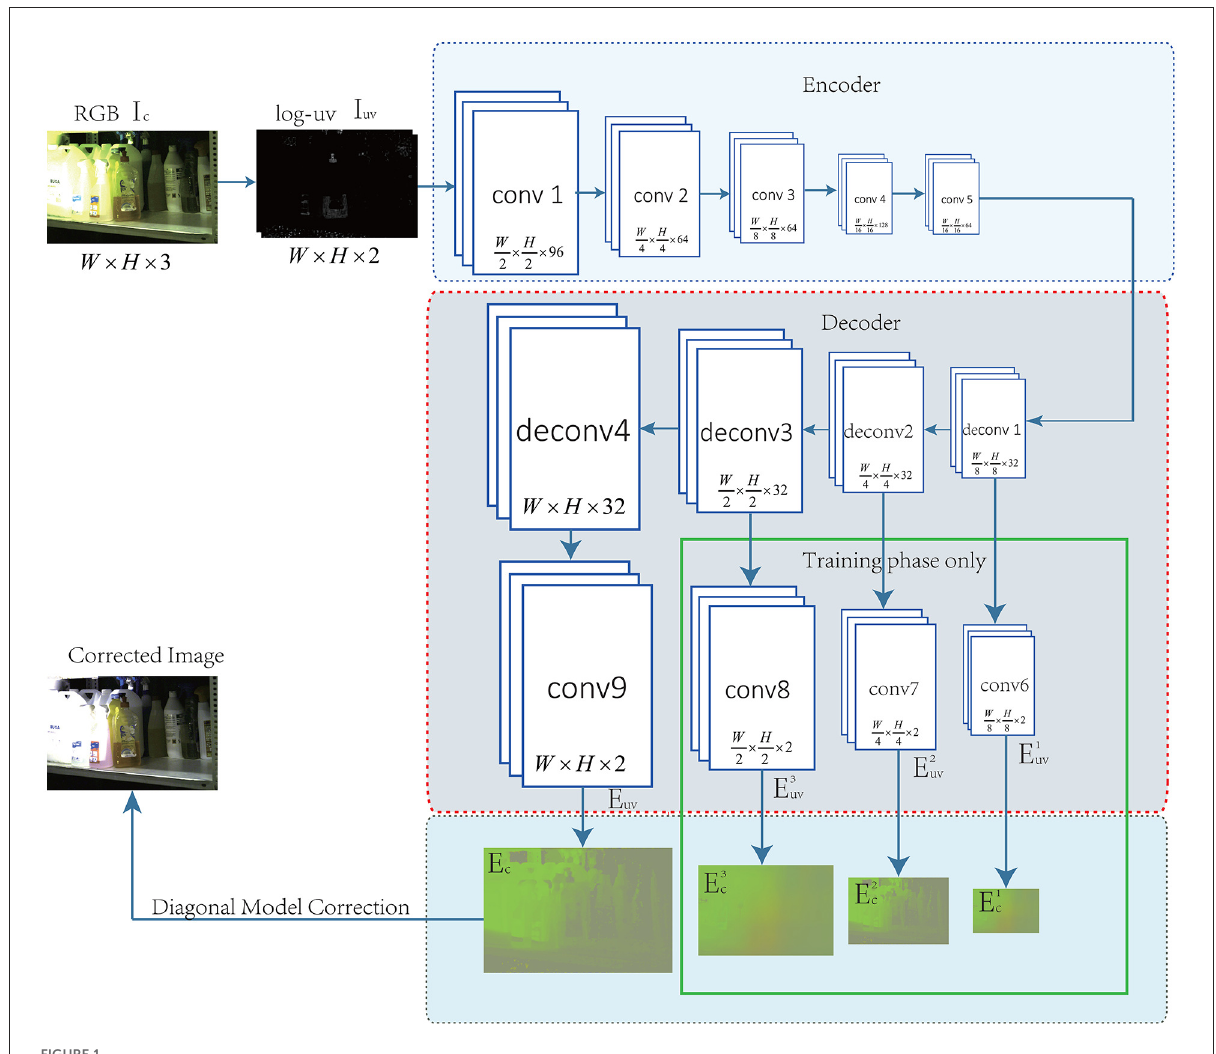
FIGURE1 The network structure of